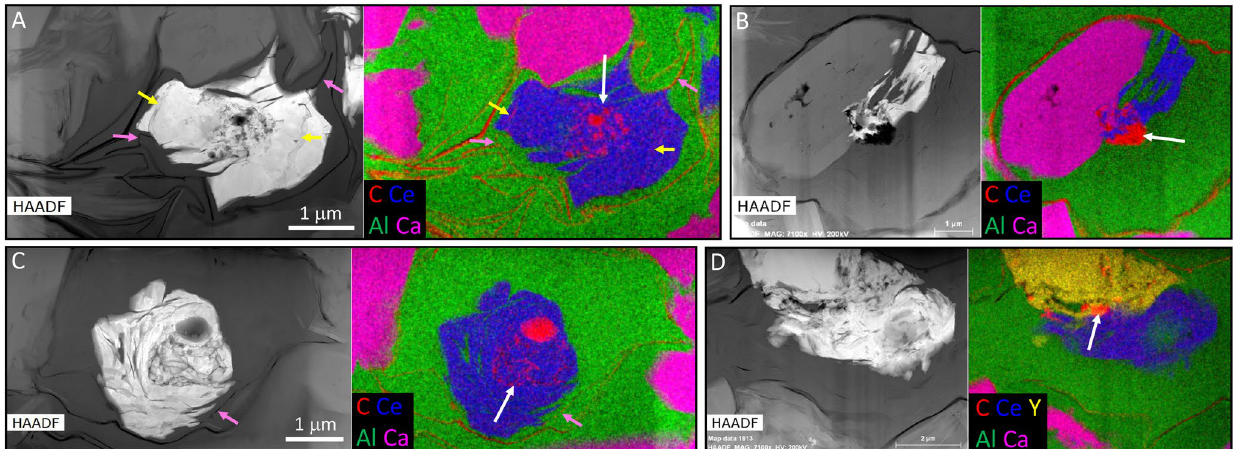
Figure 5. Chemistry of REE phosphates and host cells. ( A , C ) Two cells from the organism illustrated in Fig. 2E showing beaded spheroidal organic ICIs (white arrows) entirely preserved in monazite (indicated by blue Ce zone in the composite maps). Note also very delicate wispy organic material preserved within the monazite (yellow arrows in A ) which also continues in a more flattened state within adjacent clay minerals (pink arrows). Note that remainder of cell is infilled with K-silicate minerals (Al, green), whereas francolite (Ca, pink) only occurs outside of these cells. ( B ) Cell from an open cluster with very distinct carbonaceous ICI (white arrow) partially mineralised by monazite (Ce, blue). ( D ) Cell from the cluster illustrated in Fig. 2B with indistinct carbonaceous ICI (white arrow) associated with both monazite (Ce, blue) and xenotime (Y, yellow). HAADF panels are high angle annular dark-field scanning transmission electron microscopy images in which low mass material (e.g., carbon) shows up black. The elemental maps were obtained using ChemiSTEM energy dispersive spectroscopy (EDS). Full sets of elemental maps for these cells are given in Figs S1–4 and EDS spectra in Fig. S5.